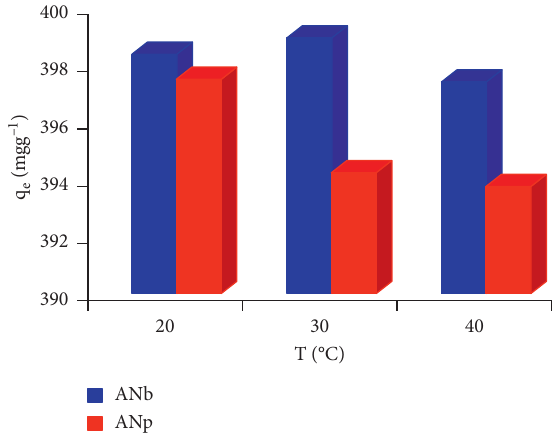
Figure 3: Effect of variation of pH of aqueous solution on raw (ANb) and purified (ANp) clays.